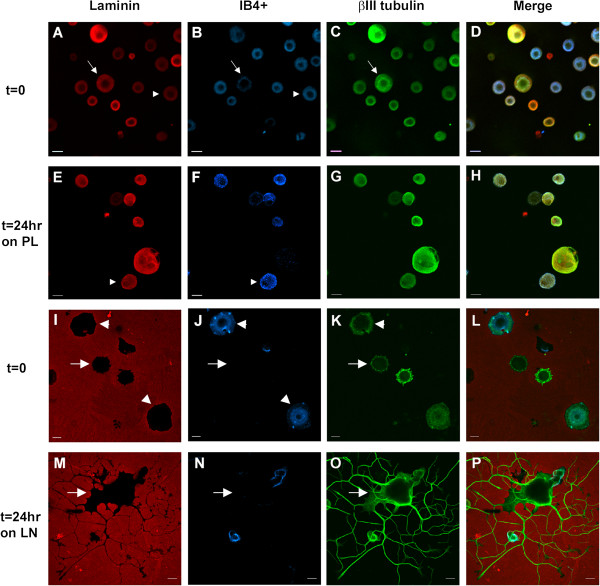
DRG neurons express LN. Dissociated DRG neurons were immunostained for laminin (red), neuron-specific βIII tubulin (green) and IB4 lectin labeling (blue) at t=0 (A-D) and t=24 hr after plating on poly-lysine (E-H). Neurons cultured on poly-lysine were used to detect the LN expression, as it was not possible to detect the cellular LN signal above the stained LN substrate. ICC quantitation showed that IB4+ cells had lower levels of LN expression at t=0 compared to the IB4- cells. Scale bar-20 μm.